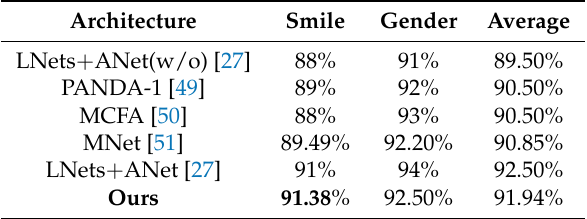
Table 3. Performance comparison for smile and gender prediction on LFWA